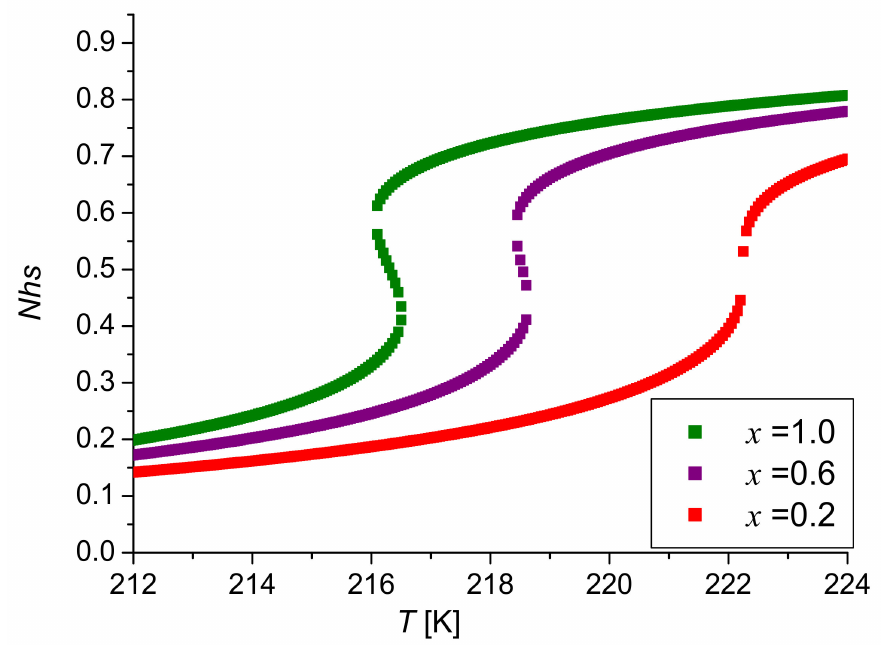
Figure 8. Thermal evolution of the HS fraction in a SCO system with a size of 10 × 10 for different values of the x parameter: x = 0.2 (red square), x = 0.6 (purple square) and x = 1.0 (green square). The computational parameters are: ∆ / k B = 1300 K, J / k B = 14.8 K, G / k B = 172.2 K and ln( g ) =